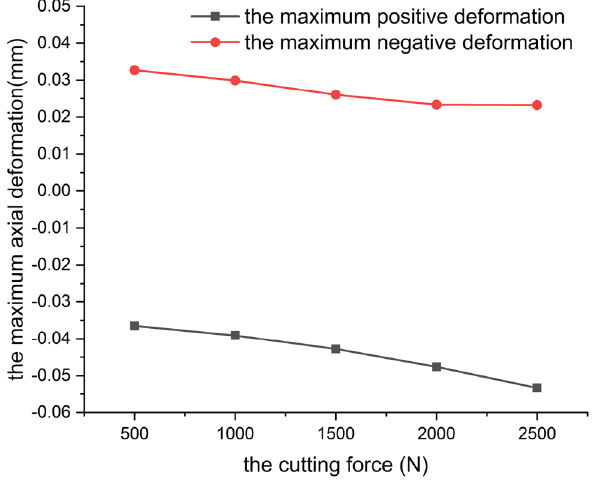
Figure 9: The in fl uence of cutting force on machining